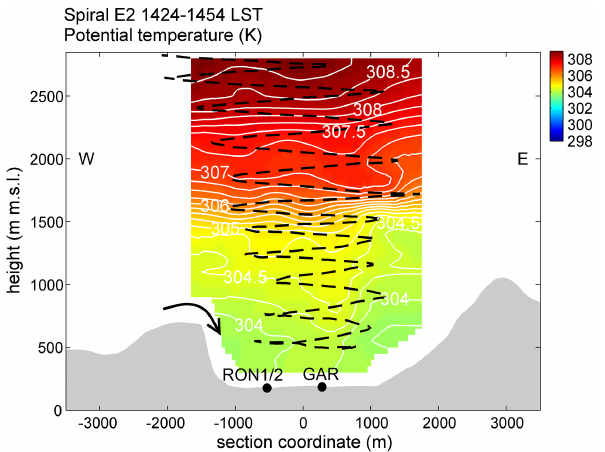
Figure 10. As in Fig. 7 but for spiral D2. The horizontal coordi- nate marks the local cross-valley direction for the Lakes Valley. The cross section is taken about 2km upstream of the Terlago saddle ridge, whose lowest point’s projection is indicated by the black ar- row. The projection of MTT’s and TER’s position is also indicated (black dots).